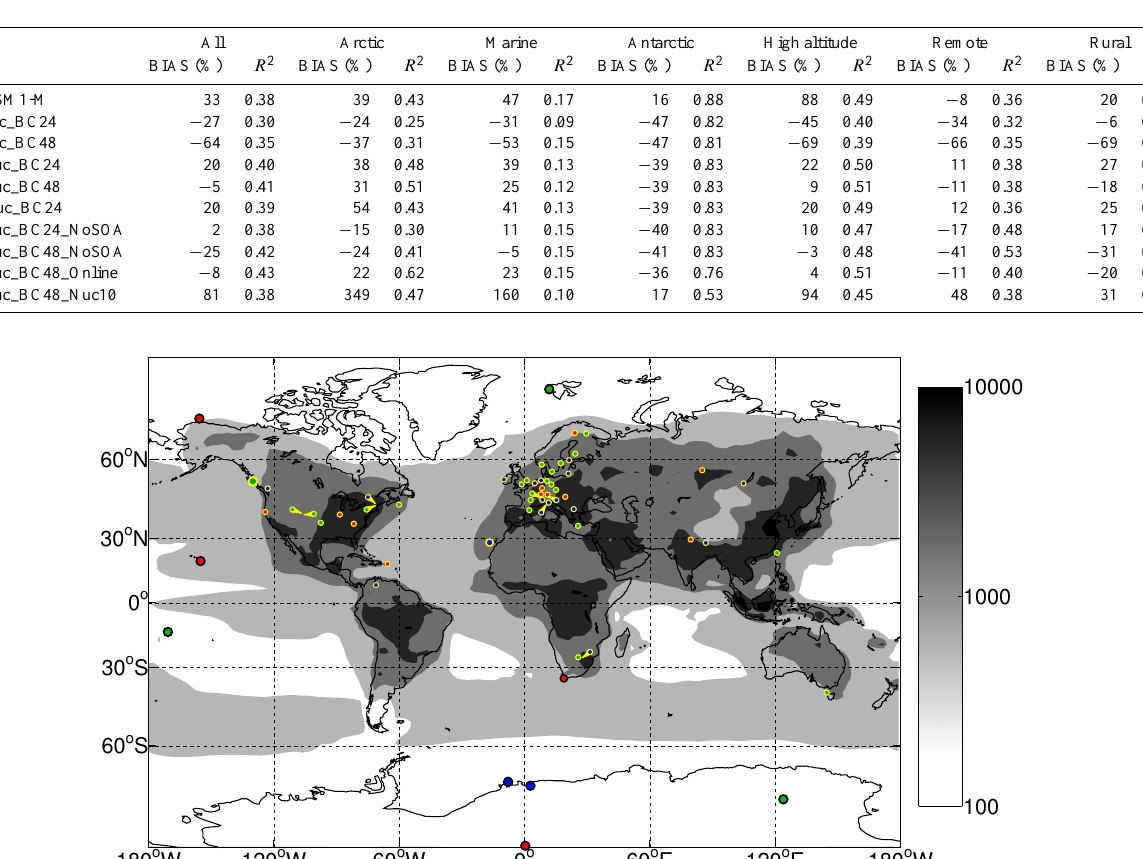
Table 3. Mean bias (%) and correlation coefficient R 2 calculated over all stations and six regions.